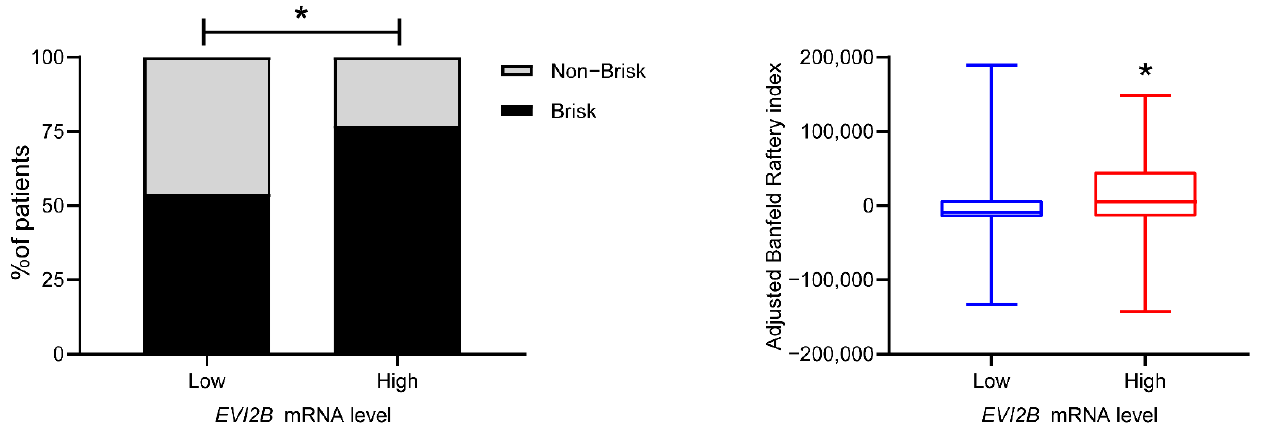
Figure 2. Spatial pattern of TILs in EVI2B high vs. EVI2B low patients: ( left ) Stacked bar plot of the distribution patterns of TILs (brisk or non-brisk), * p < 0.05 by Fisher’s exact test; ( right ) adjusted Banfield and Raftery index of TILs clustering patterns, *: p < 0.05 by Mann–Whitney test.